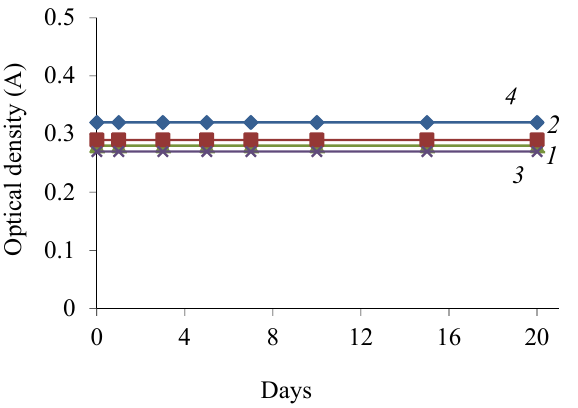
Fig. 9. Change in the intensity of color of the brilliant blue dye in the aqueous solutions without organic impurities ( 4 ) and those that contain trichlorethylene ( 1 ), dichloroethane ( 2 ) and chloroform ( 3 ) over time.